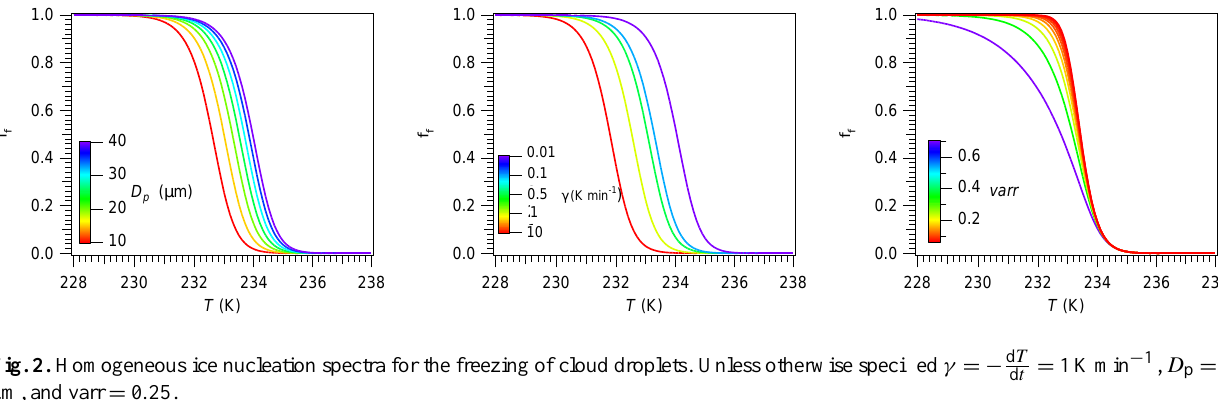
Fig. 2. Homogeneous ice nucleation spectra for the freezing of cloud droplets. Unless otherwise specified γ = − d T = 1 K min − 1 , D p = 20 µm, and varr = 0 . 25 . d t